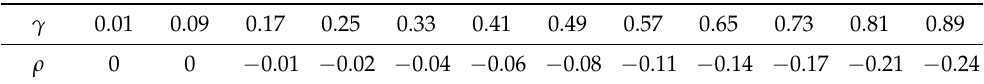
Table 10. Values of the rho of Spearman of the SGCC copula for θ = ( − γ ,1/ values of γ ∈ ( 0,1 ] , belonging to Configuration